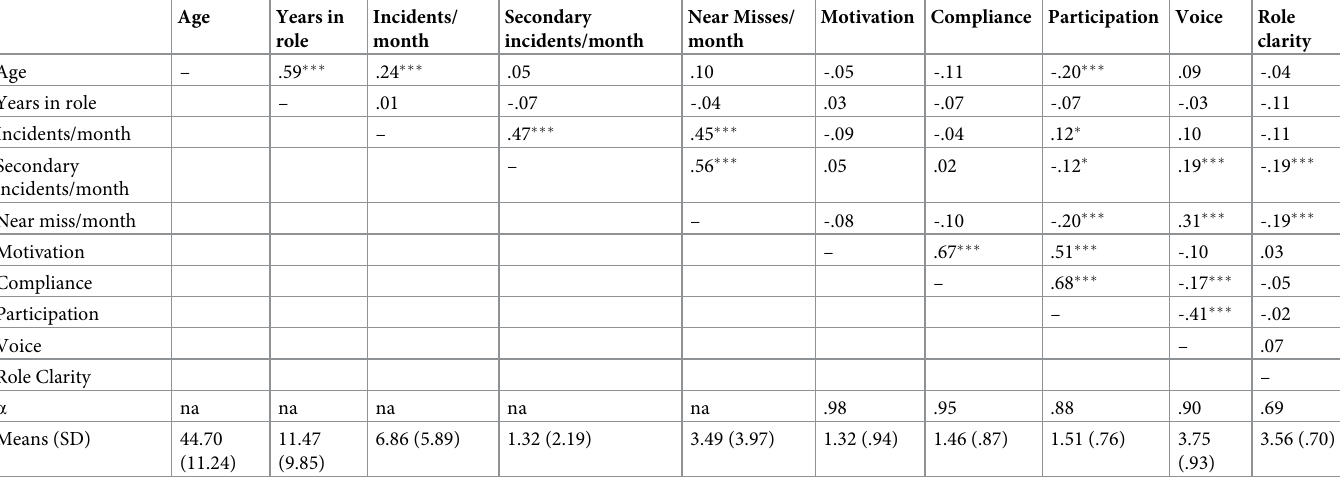
Table 2. Intercorrelations among variables (with Means and